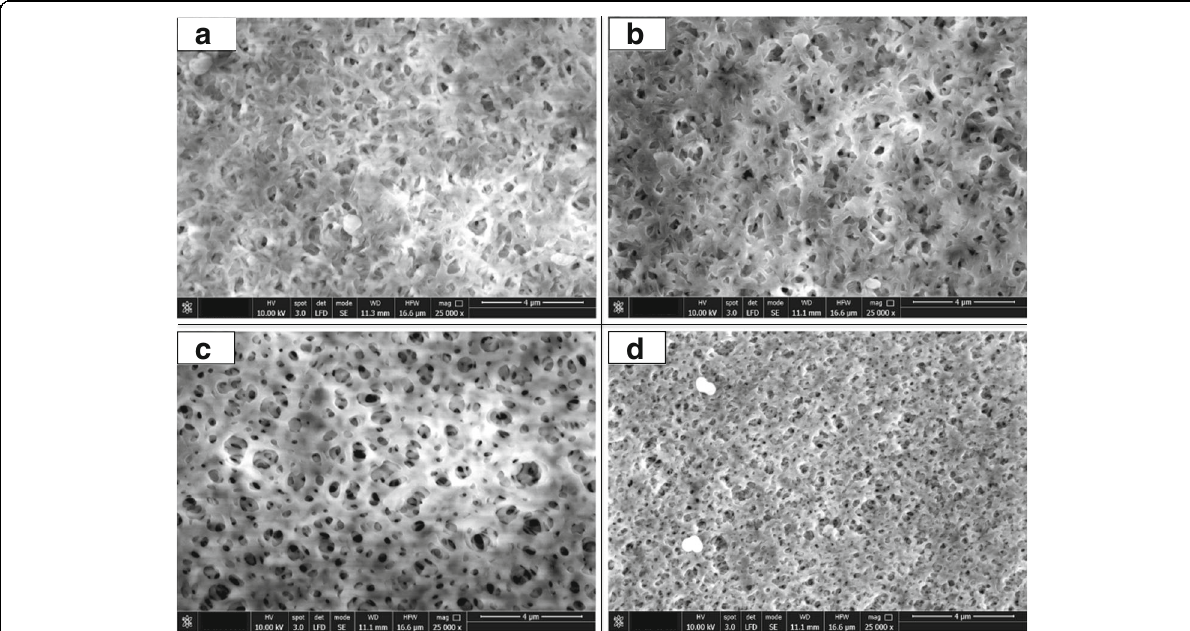
Fig. 3 SEM images at 25,000x of ( a ) untreated nylon membranes, ( b ) perfluorohexane plasma treatment of nylon membranes, ( c ) untreated PES membranes and ( d ) perfluorohexane plasma treated PES membranes